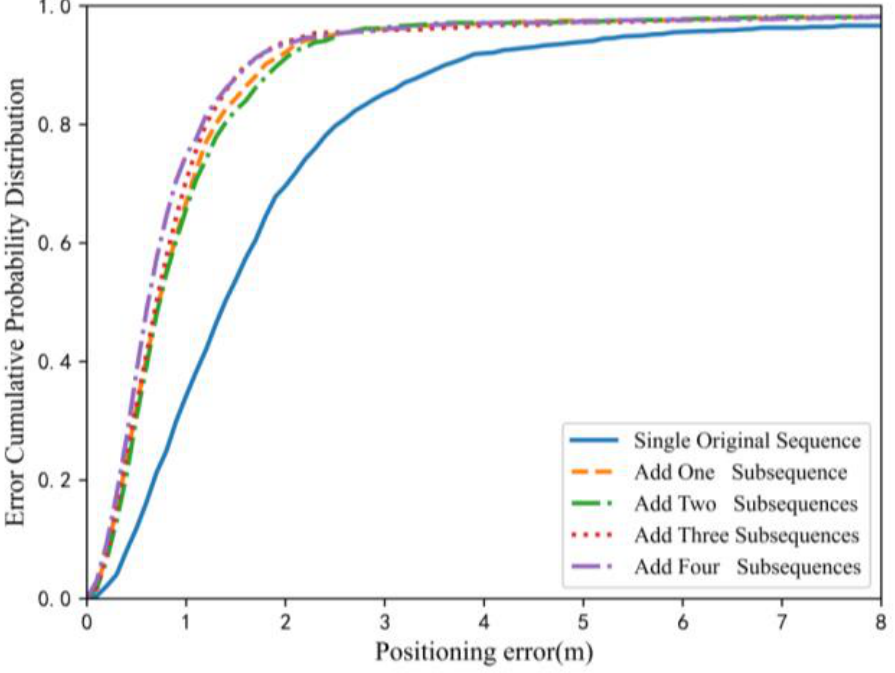
Figure 8. CDF of multi-scale sequence positioning error (the solid line indicates that only the original magnetic sequence was input, and other lines indicate that there were subsequences decomposed from the original sequence apart from the original sequence.).